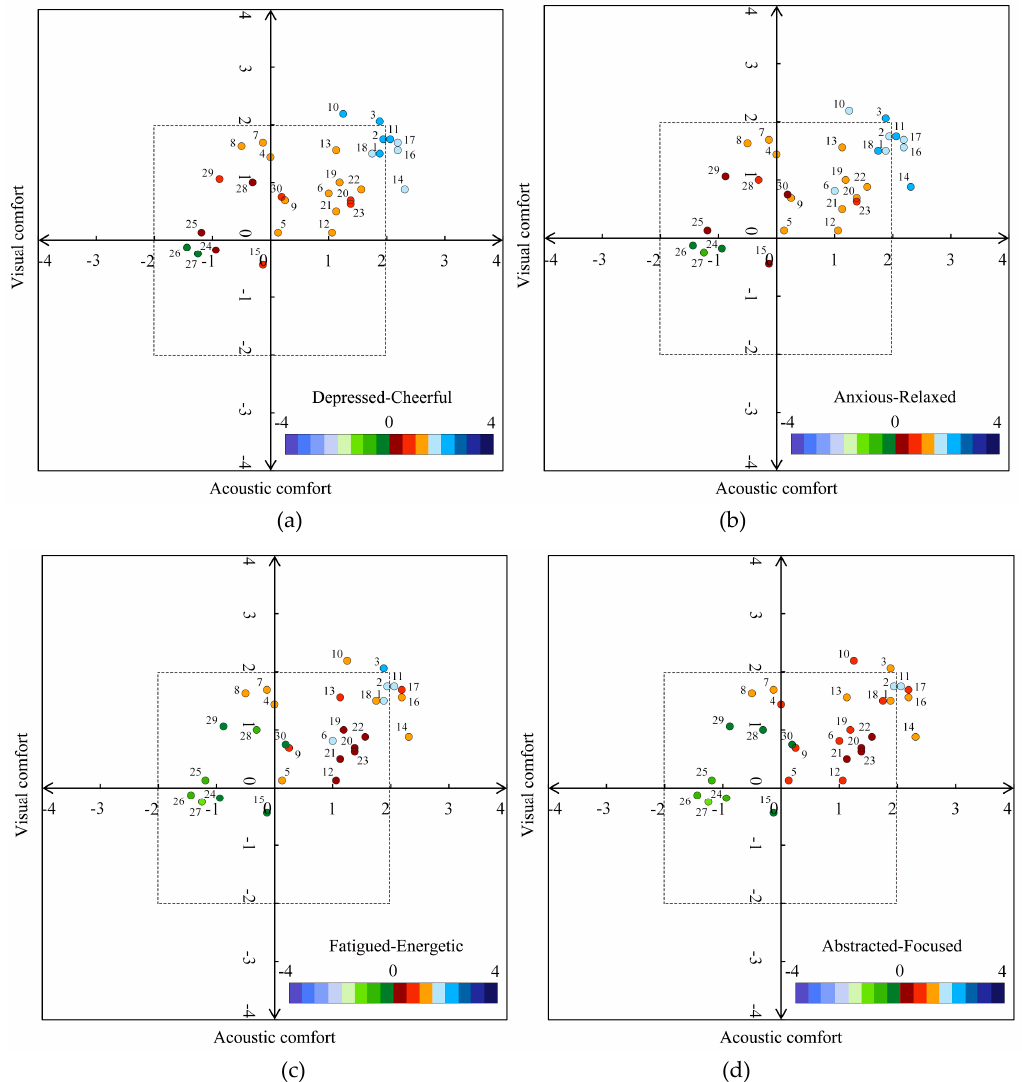
Figure 2. Orthogonal analysis of audio-visual experiences on psychological responses: ( a ) CD; ( b ) RA; ( c ) EF; ( d ) focused-distracted (FD) in Music Park.